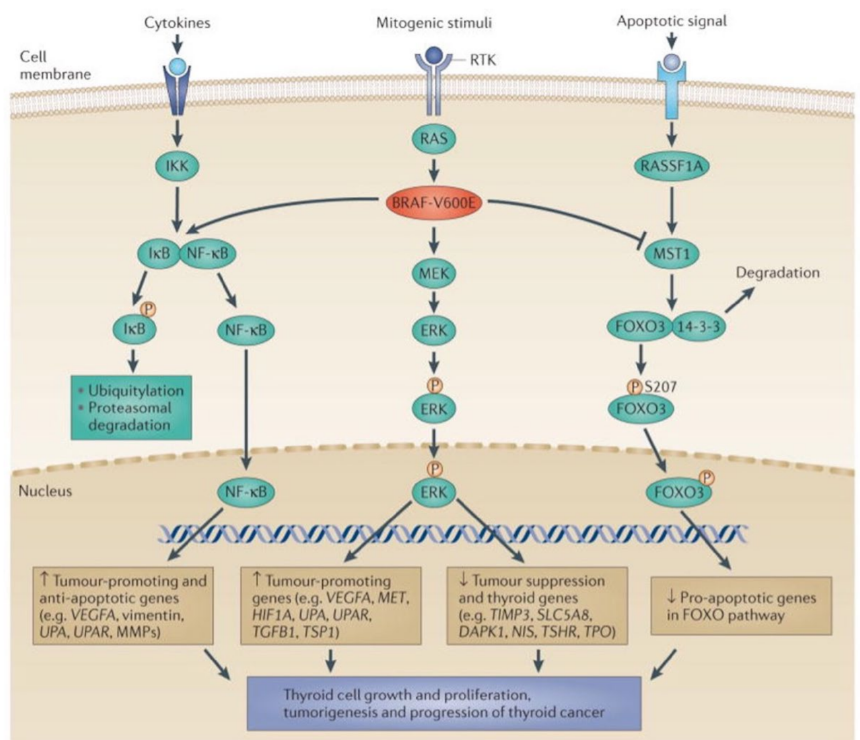
Figure 1. The MAPK and related pathways in thyroid cancer. Shown in the ( middle ) of the figure is the classical MAPK pathway leading from an extracellular mitogenic stimulus that activates a receptor tyrosine kinase (RTK) in the cell membrane, to RAS, RAF (shown as BRAF-V600E), MEK and ERK. ERK enters the nucleus where it upregulates tumor-promoting genes and downregulates tumor suppressor genes and thyroid iodide-handling genes. On the ( left ) side of the figure is the nuclear factor- κ B (NF- κ B) pathway, in which extracellular stimuli activate the pathway, leading to activation of the inhibitor of κ B (I κ B) kinase (IKK), resulting in the phosphorylation of I κ B. I κ B becomes dissoci- ated from NF- κ B and then enters the nucleus to promote the expression of tumor-promoting genes. Through an undefined mechanism, BRAF-V600E promotes the phosphorylation of I κ B and the release of NF- κ B, thus activating the NF- κ B pathway. Shown on the ( right ) side of the figure is the RASSF1– mammalian STE20-like protein kinase 1 (MST1)–forkhead box O3 (FOXO3) pathway. Activated by extracellular pro-apoptotic stimuli, RASSF1A activates MST1which phosphorylates FOXO3. The resulting phosphorylated FOXO3 becomes dissociated from 14-3-3 proteins and enters the nucleus to promote the expression of pro-apoptotic genes in the FOXO pathway. BRAF-V600E directly inhibits MST1 and prevents its activation by RASSF1A, thereby suppressing the pro-apoptotic signaling of the FOXO3 pathway. The downward arrow for the FOXO activities shown in the nucleus indicates this negative effect of BRAF-V600E on pro-apoptotic genes. DAPK1, death-associated protein kinase 1; HIF1A, hypoxia-inducible factor 1 α ; MMP, matrix metalloproteinase; NIS, sodium–iodide sym- porter; TGFB1, transforming growth factor β 1; TIMP3, tissue inhibitor of metalloproteinases 3; TPO, thyroid peroxidase; TSHR, thyroid-stimulating hormone receptor; TSP1, thrombospondin 1; UPA, urokinase plasminogen activator; UPAR, urokinase plasminogen activator receptor; VEGFA, vascular endothelial growth factor A. Figure reprinted from Ref. [79], by